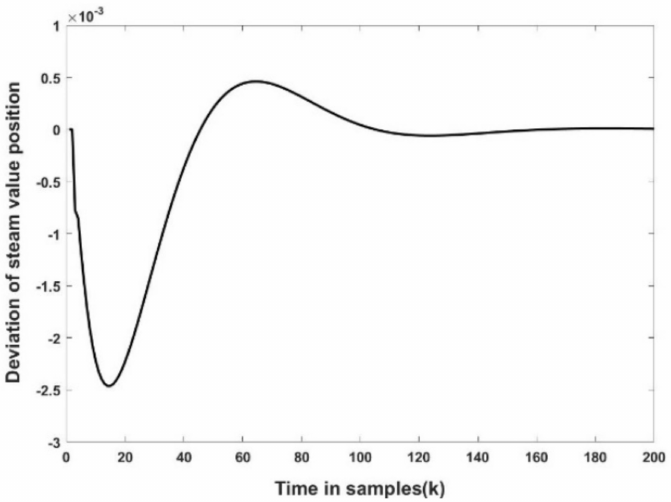
Figure 9. Dynamic response of mechanical power using IPSO-BP-PI technique.